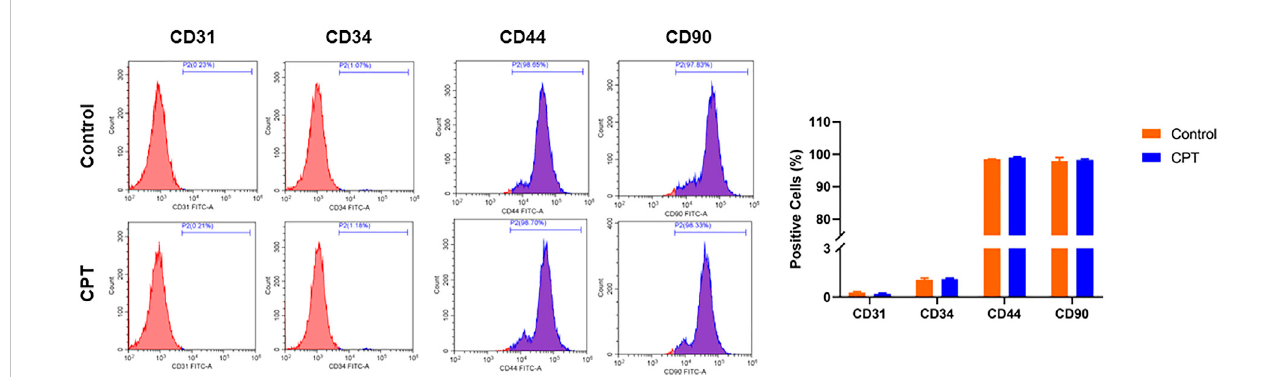
FIGURE 2 Flow cytometry was used to detect the positive ratio of molecular markers CD31, CD34, CD44 and CD90 of puri fi ed PSCs derived from different periosteal tissues. PSCs, periosteal stem cells.